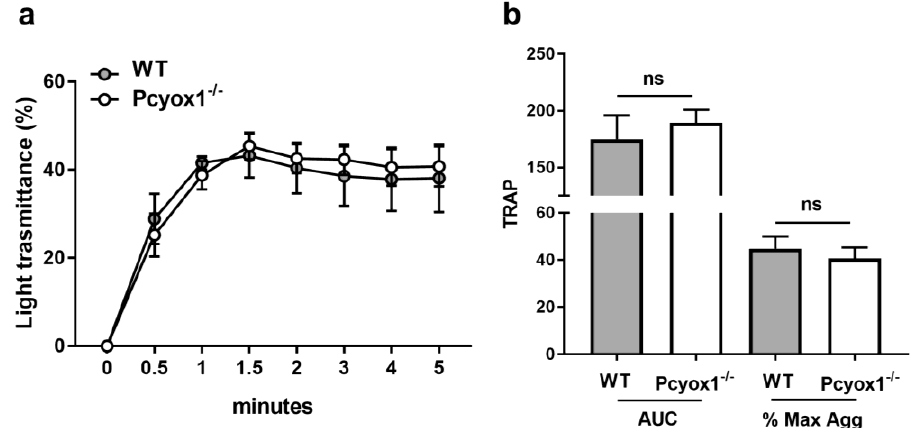
Figure 6. Aggregation of washed platelets isolated from the WT and Pcyox1 − / − mice. Platelet aggregation was performed in washed platelets in response to subthreshold concentration of TRAP. Data are shown as ( a ) kinetic of light transmission and ( b ) area under the curve (AUC) and % of maximum aggregation (% Max Agg) during the 5 min of recording. (Grey bar: WT mice; white bar: Pcyox1 − / − mice). n = 7 mice/group. Data are shown as mean ± SEM. ns = not significant at Mann–Whitney U-test.